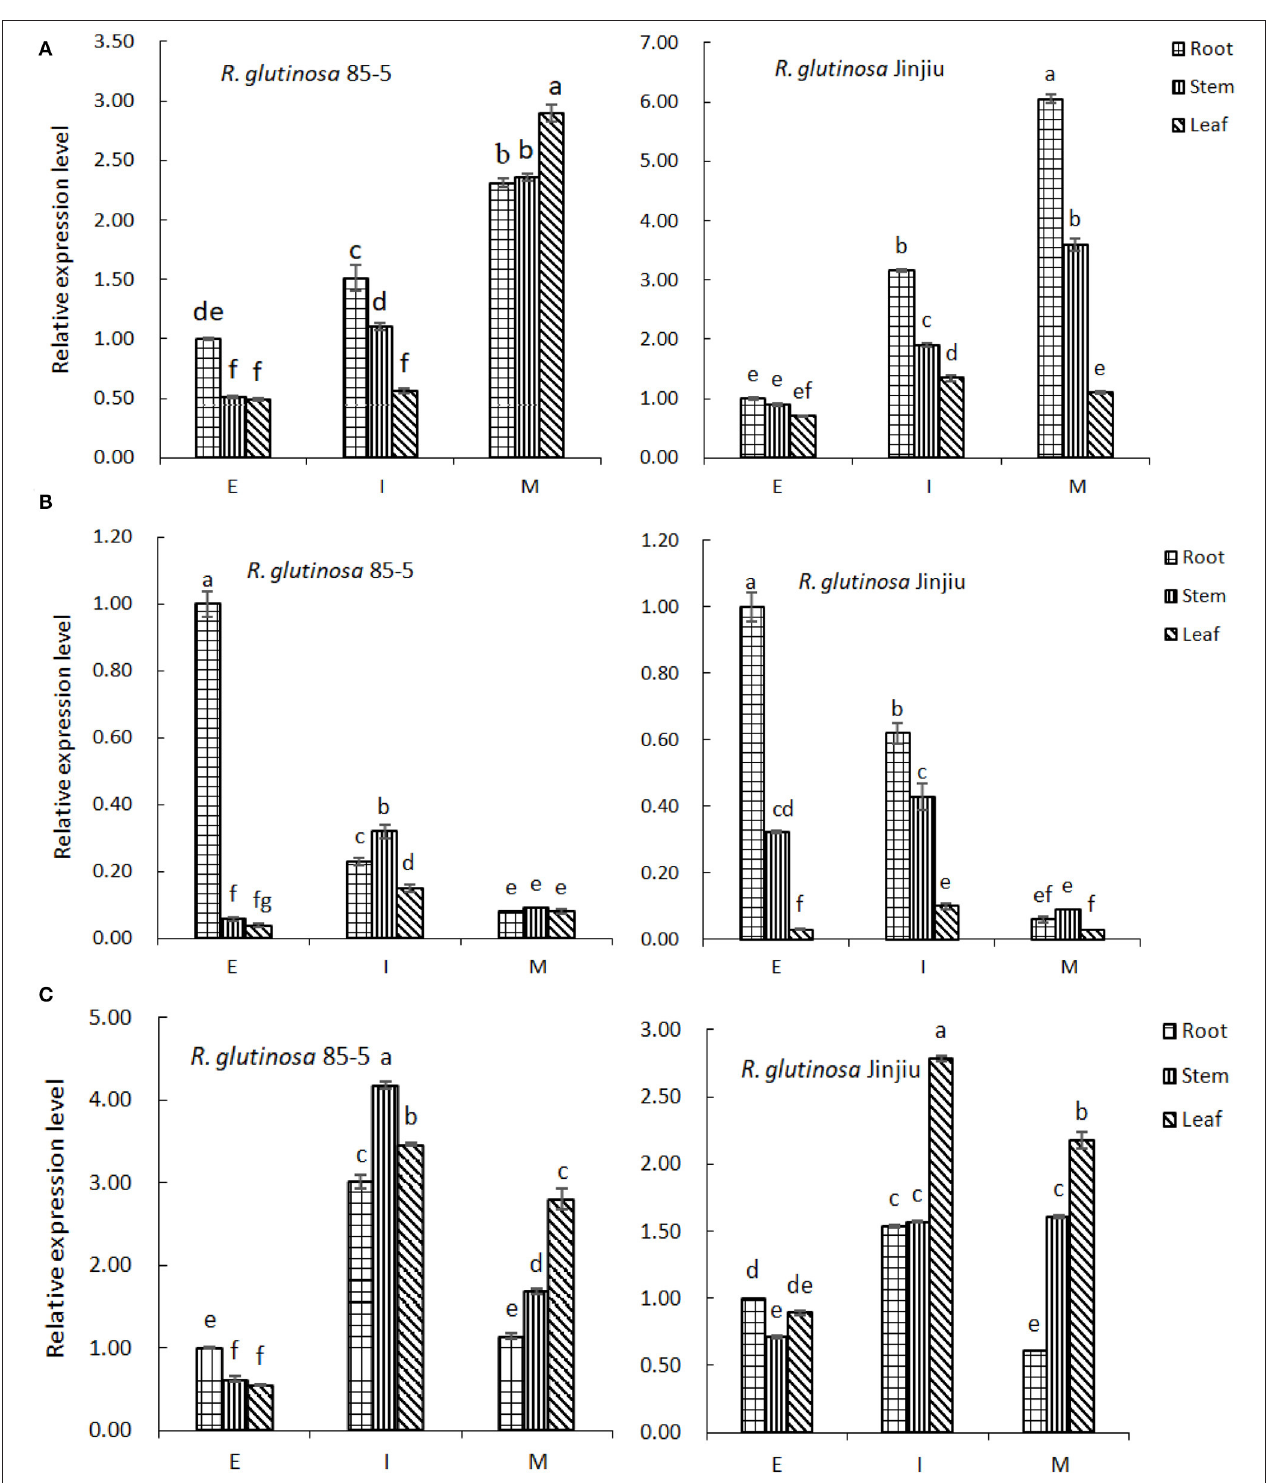
FIGURE 7 | The expression pattern of FPP/GGPP gene in R. glutinosa. (A–C) represents the relative expression of FPPS , GGPS, or GPPS in R. glutinosa 85-5 and R. glutinosa Jinjiu, E, I, and M respectively represents elongation stage, expansion stage, and maturation stage of R. glutinosa . The error bar is standard error of mean, and the lower letter above the bar indicated the significant difference in root, stem, or leaf among the different growth stages of R. glutinosa ( P < 0.05).